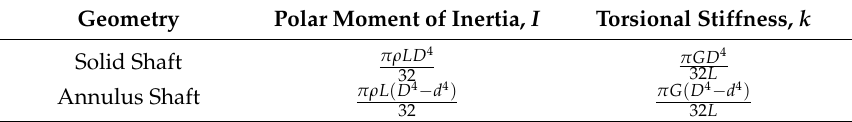
Table 5. Shaftline mass-spring modelling properties.